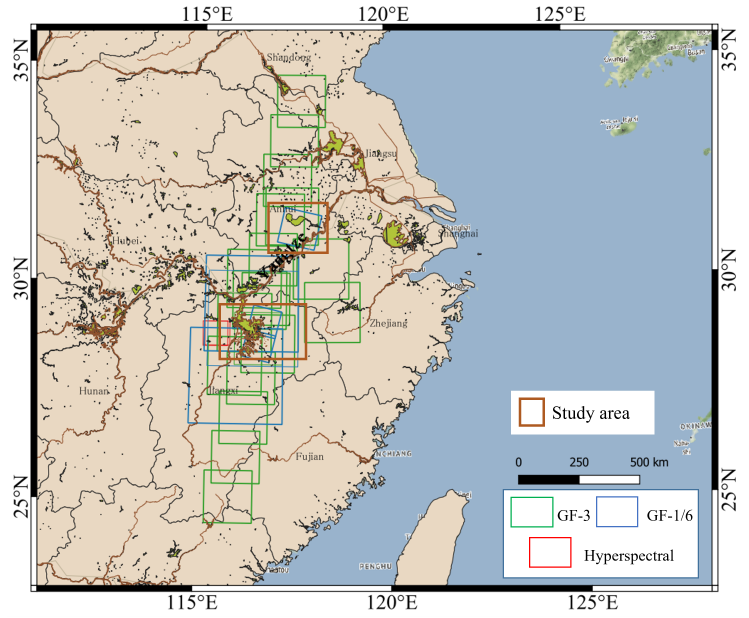
Figure 1. Study area and used datasets in this